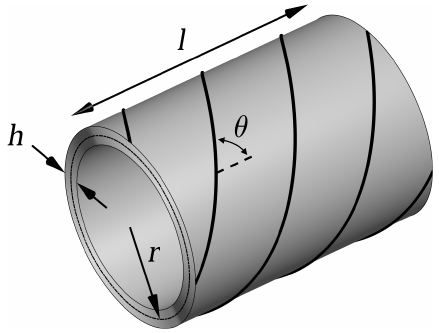
Figure 1. Laminated composite